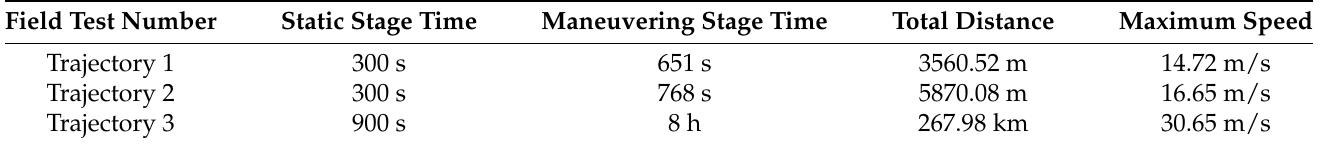
Figure 16. Field test trajectories. Table 4. The arrangements of the field